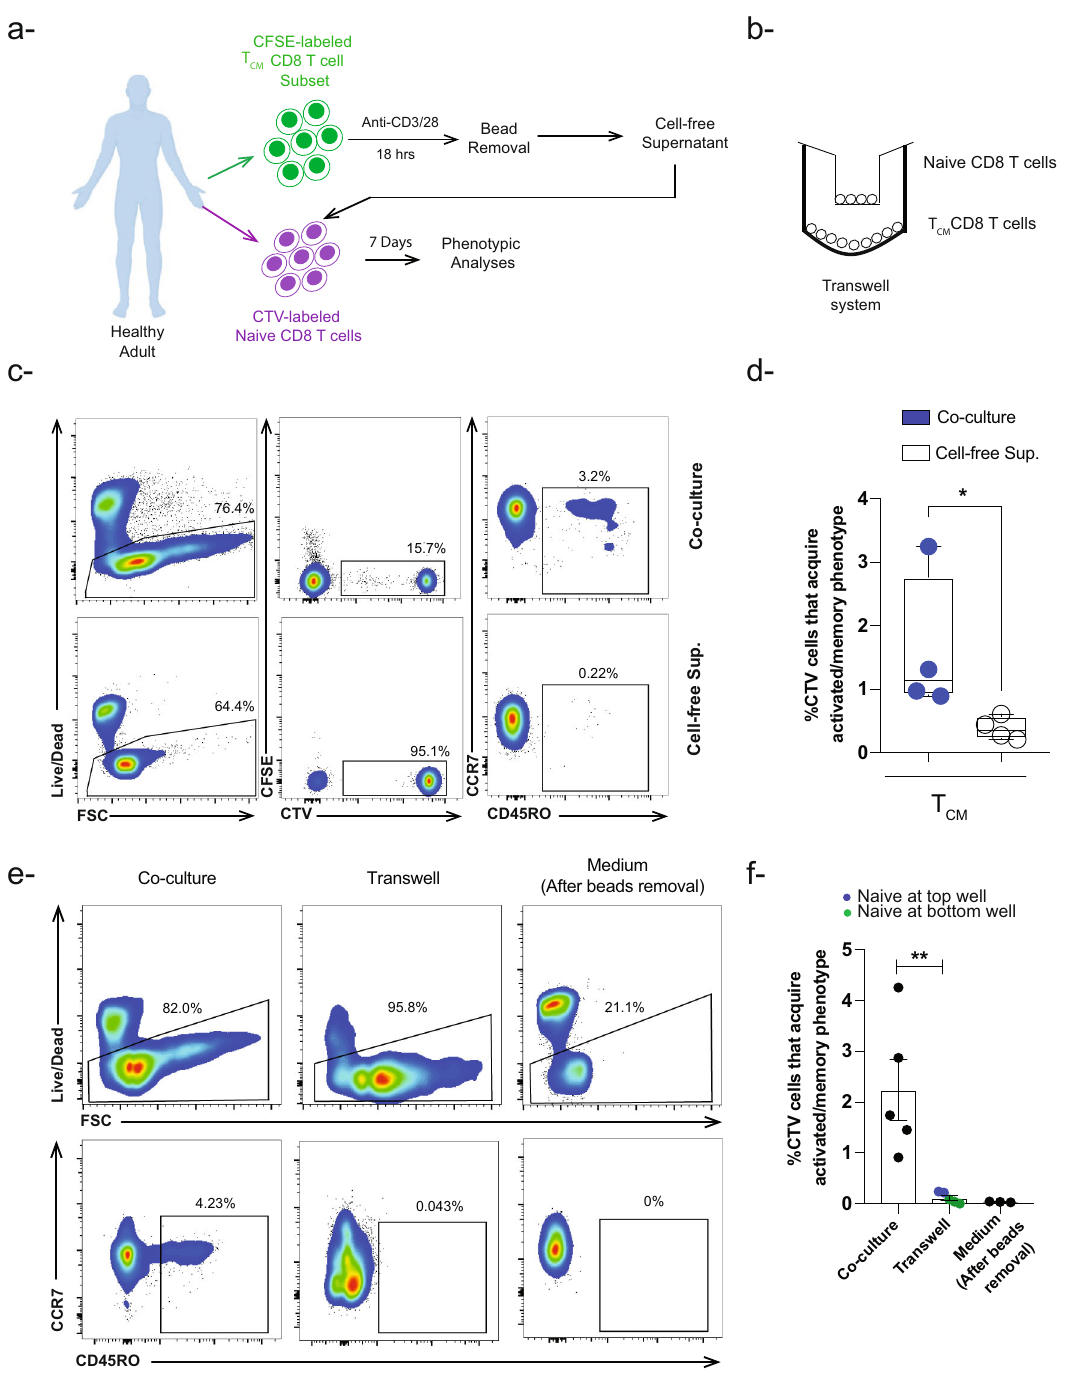
Fig. 4 Naïve CD8 T cells require cell-to-cell contact to acquire activated/memory phenotype. a Schematic view of the experimental approach showing that naïve and memory T CM CD8 T cells were sorted from healthy adults then labeled with CTV and CFSE respectively. CFSE-labeled T CM cells were stimulated with anti-CD3/CD28 beads (1:1 ratio). After overnight stimulation, beads were removed by plate magnet followed by collection of cell-free supernatant, which then was added to unmanipulated CTV-labeled naïve CD8 T cells. Following 7 days of incubation, activated/memory T cell phenotype was examined in CTV-labeled naïve CD8 T cells. b Schematic view of the transwell system experimental approach showing sorted naïve CD8 T cells were cultured on the top well of transwell system while activated memory T CM CD8 T cells were cultured at the bottom well. c Representative fl ow cytometry plots and d Box plot showing the incidence of CTV-labeled naïve CD8 T cells that acquired activated/memory phenotype in the presence of cell- free supernatant from stimulated T CM CD8 T cells compared to co-culture conditions ( n = 4). e Representative fl ow cytometry plots and f Bar-graph showing the incidence of CTV-labeled naïve CD8 T cells that acquired an activated/memory phenotype (upregulation of CD45RO) in the presence of stimulated T CM CD8 T cells but separated from each other using the transwell system compared to co-culture conditions ( n = 5). Blue closed circles depict conditions were naïve CD8 T cells were cultured at the top ( n = 2) while green closed circles represent conditions were naïve CD8 T cells cultured at the bottom ( n = 3). To examine if there was a carry-over effect of beads following beads removal, medium was added to CTV-labeled naïve CD8 T cells after beads removal ( n = 3). **P < 0.01 * P < 0.05 Unpaired nonparametric Mann-Whitney test was used. Data are presented as means ±